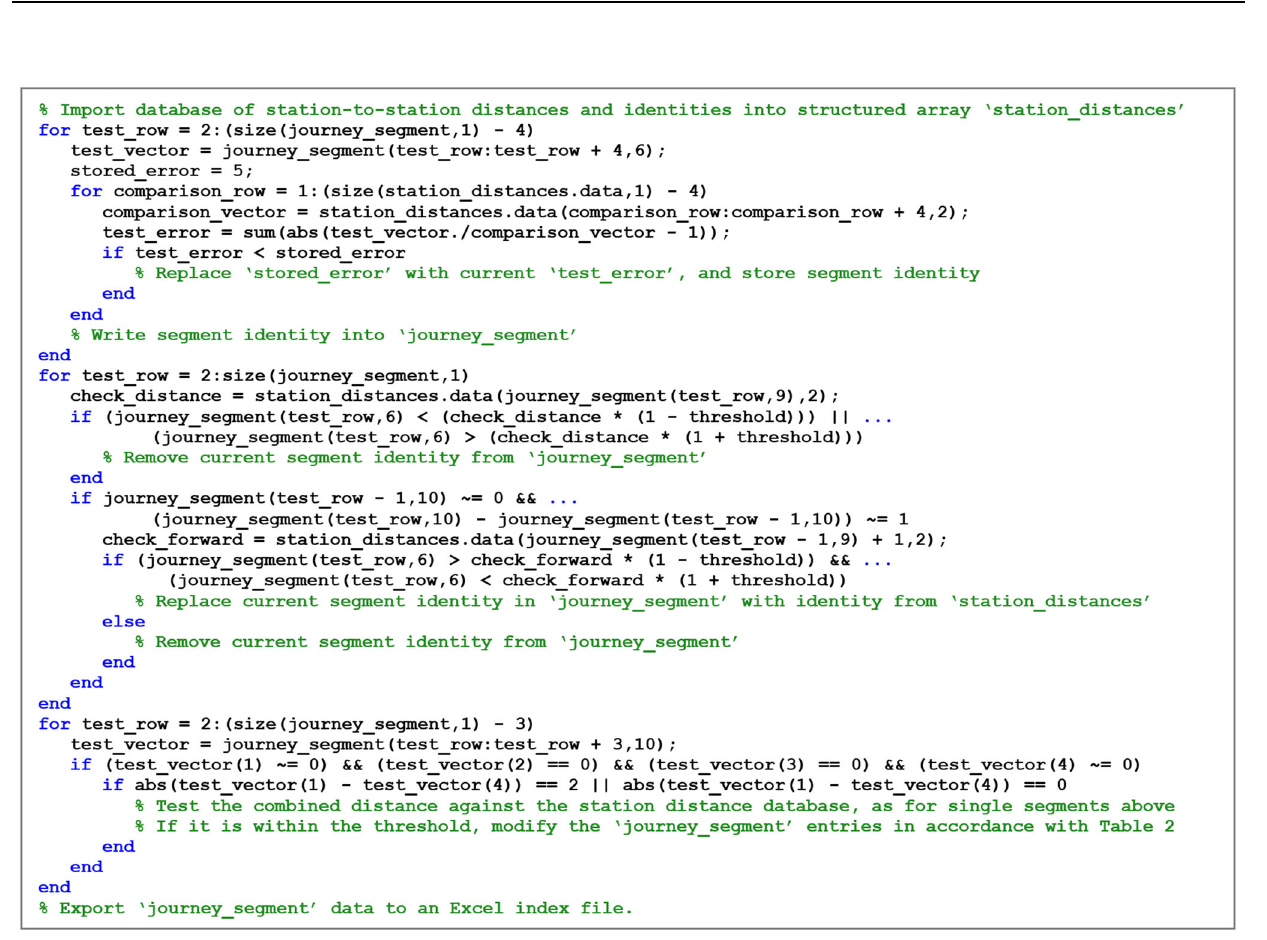
Fig. 3 Pseudocode for the filtering classification algorithm Pseudocode for the initial classification algorithm can be obtained by removing the third FOR